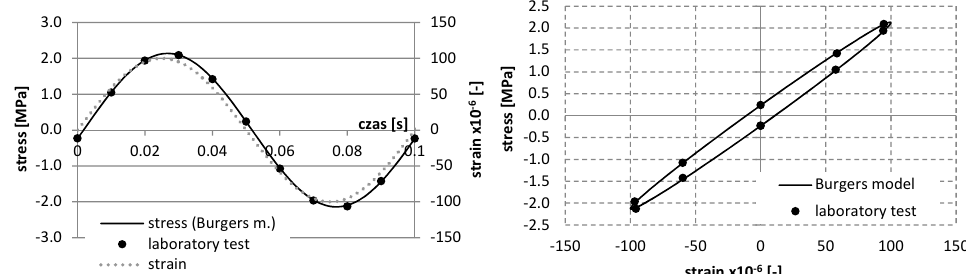
Figure 8. The results of laboratory study and the approximation of curves σ – ε using the Burgers model in the dynamic test at the temperature 0 °C (asphalt mixtures with an asphalt content of 4.5%).